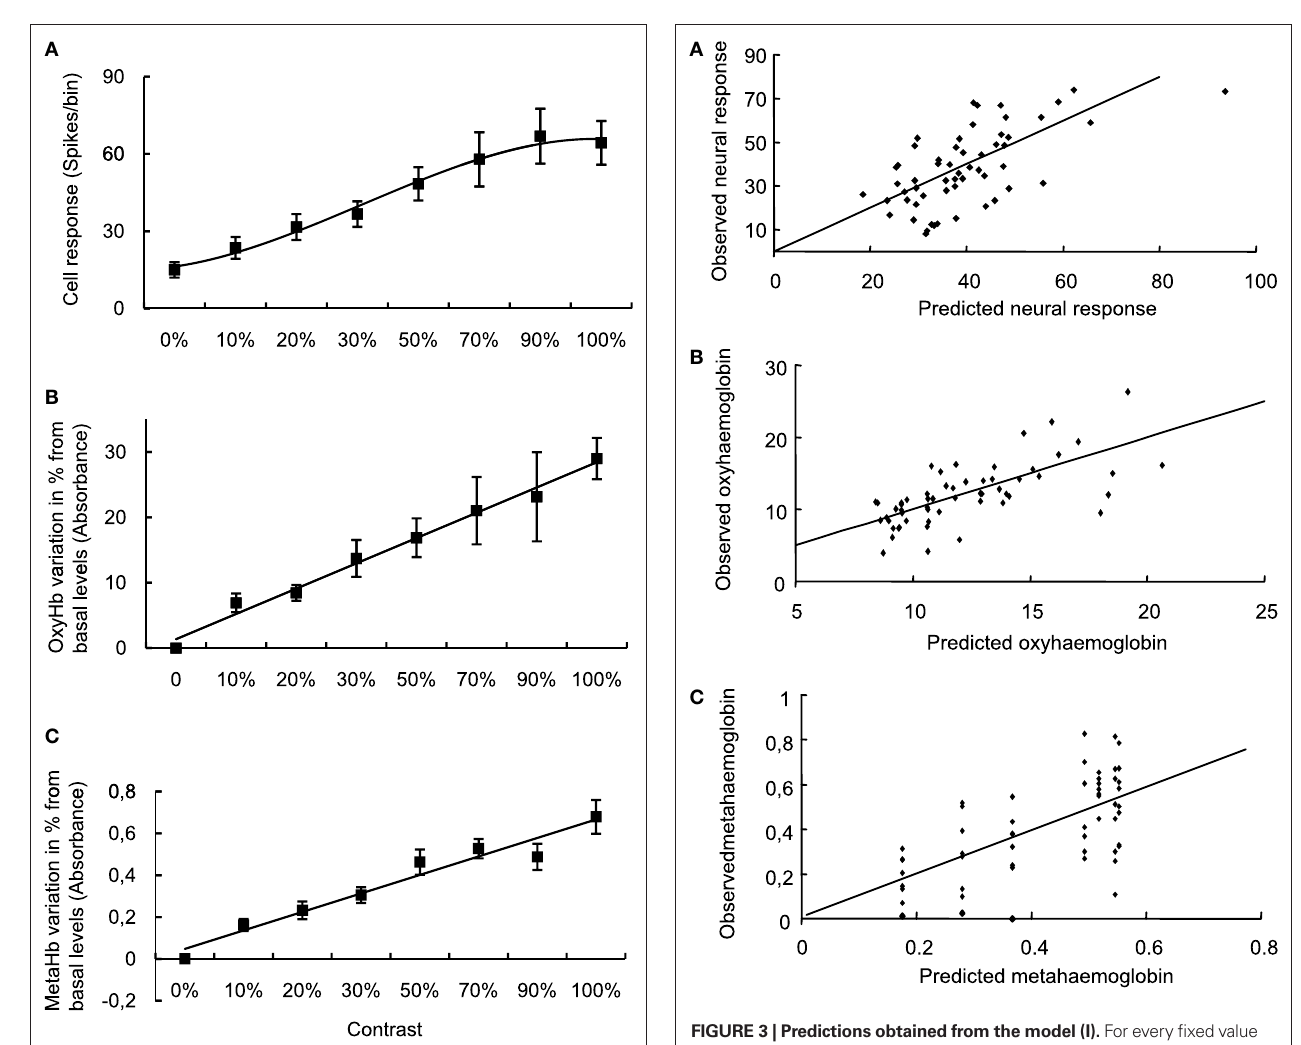
FIGURE 3 | Predictions obtained from the model (I). For every fi xed value of the ST, the experiment was repeated several times obtaining different values of OxyHb (% of baseline), MetHb (% of baseline) and neuronal response. Predicted-observed plot for neuronal responses (A) , OxyHb (B) and MetHb (C) using the multiple polynomial regression model presented above. The horizontal axis denotes the predicted values, while the vertical axis represents the observed values. The straight line is the diagonal accounting for perfect